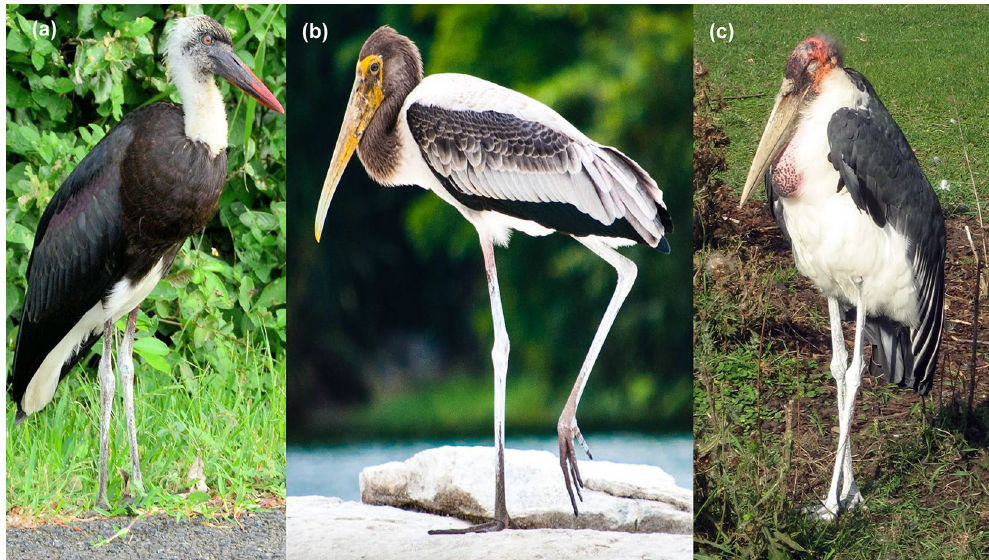
Figure 1. Examples of urohidrosis in different stork species: ( a ) woolly-necked Ciconia episcopus , ( b ) painted Mycteria leucocephala and ( c ) marabou Leptoptilos crumenifer storks. In the first two, the whitish residue produced by urohidrosis covers partially the limbs with feet showing its natural darker colour. In the case of marabou, excreta covers completely the limbs, including the feet. Credit for images: woolly-necked stork – Ossewa (distributed under CC BY-SA 4.0 license; https:// creat iveco mmons. org/ licen ses/ by- sa/4. 0/), painted stork – Unni Hariharan (CC BY-SA 4.0; https:// creat iveco mmons. org/ licen ses/ by- sa/4. 0/) and marabou – Dezidor (CC BY 3.0; https:// creat iveco mmons. org/ licen ses/ by/3.